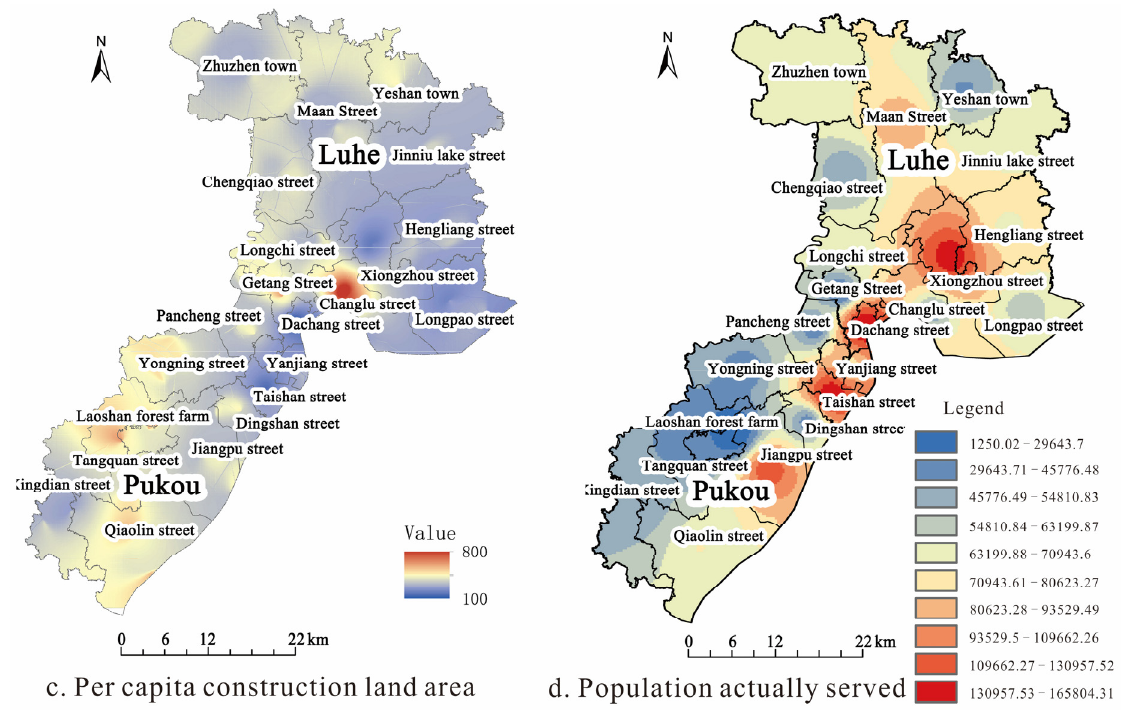
Figure 3. Spatial analysis of PL flow in NJNA.